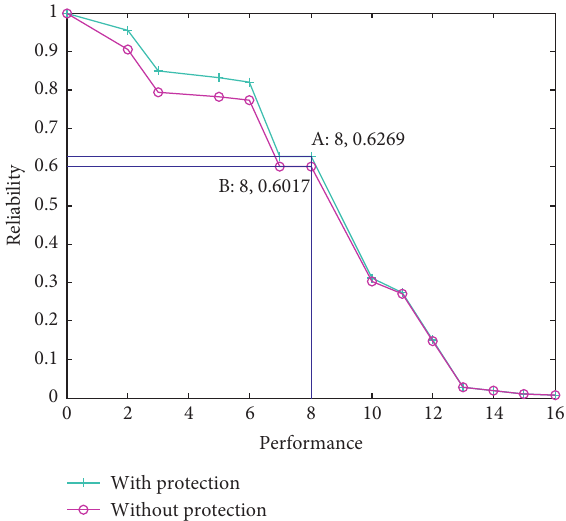
Figure 4: Reliability function of system with and without